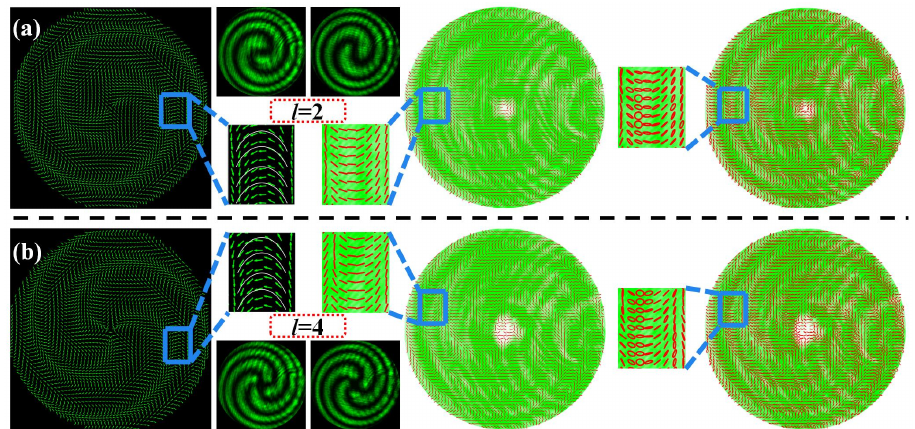
Figure 6. Generated vector beams with the desired phase profile δ 2 of Equation (12). ( a , b ) Generated vector beams with topological charges of l = 2, and 4, respectively.